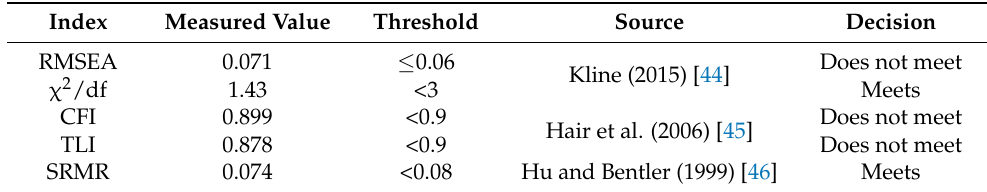
Table 7. Goodness-of-fit measurements of the